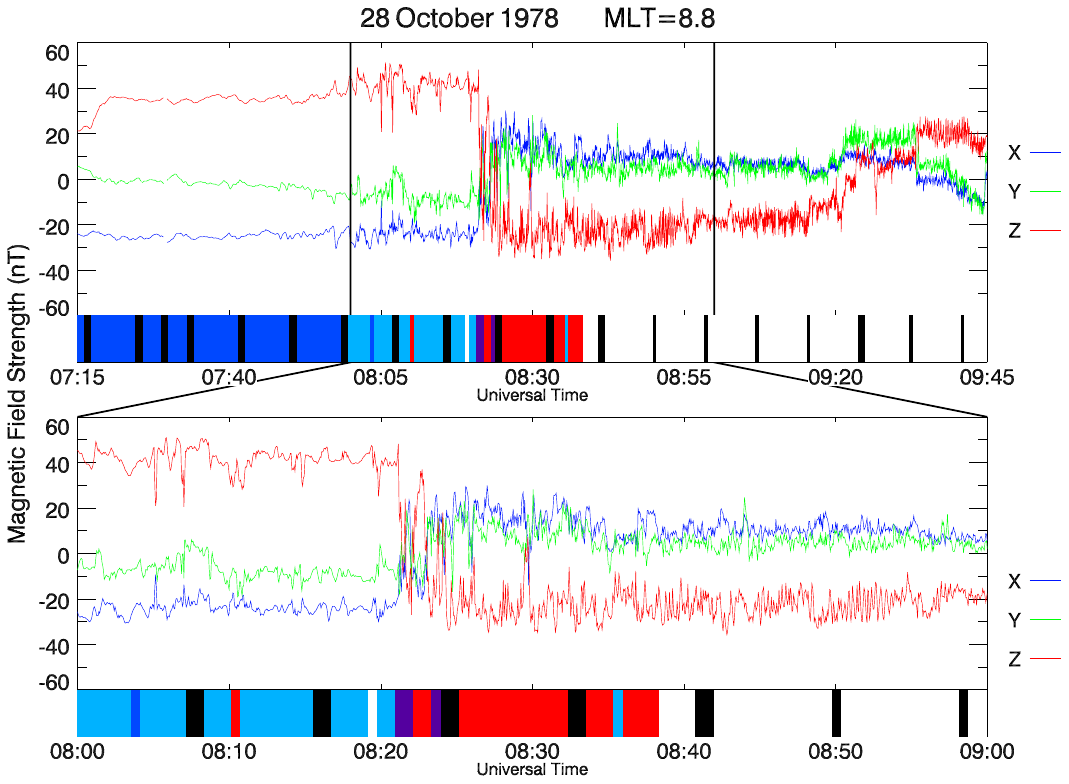
Fig. 6. A plot in the format of Fig. 4 for 28 October 1978 (Day 301) from 07:15UT to